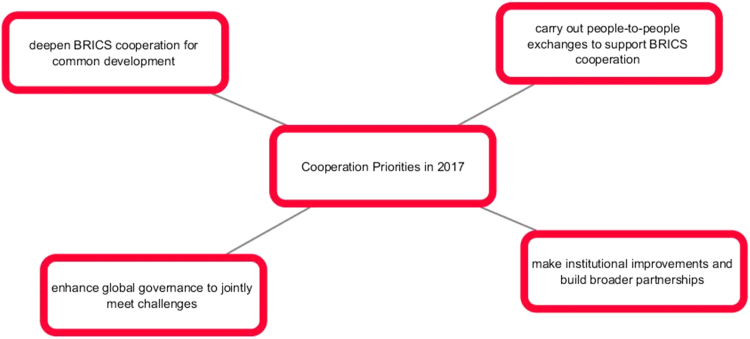
Cooperation priorities of Xiamen summit in 2017 [3].